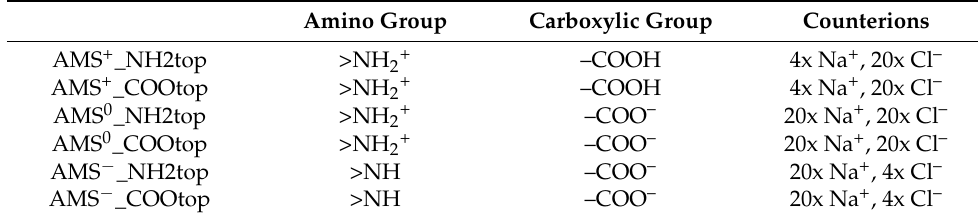
Table 1. The composition of the simulated